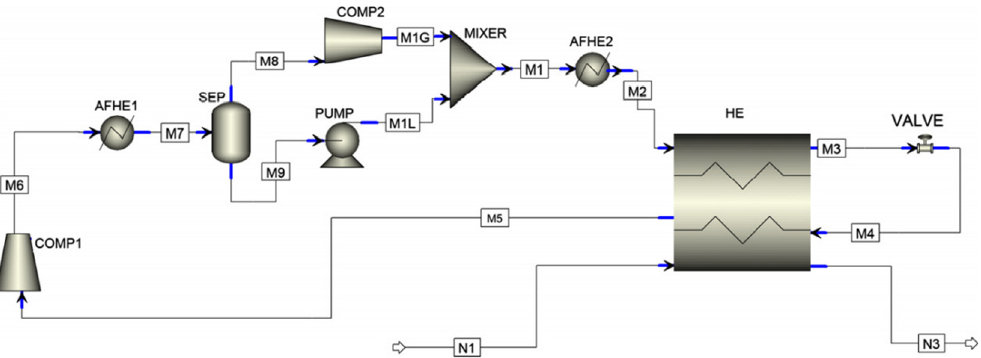
Reproduced with permission from Elsevier (license number 5413460329927). Figure 29. Flow sheet of the PRICO process [97].